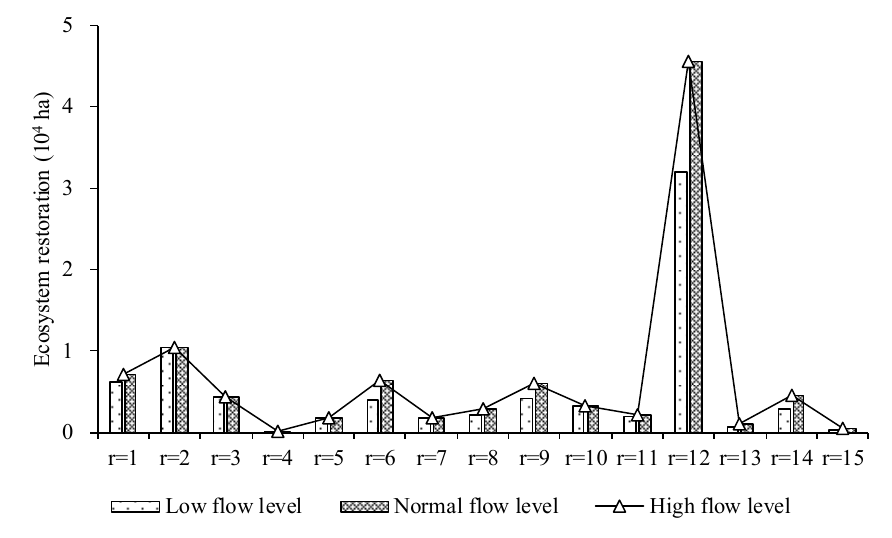
Figure 4. Sizes of restored water surface areas in western Jilin Province under different scenarios.